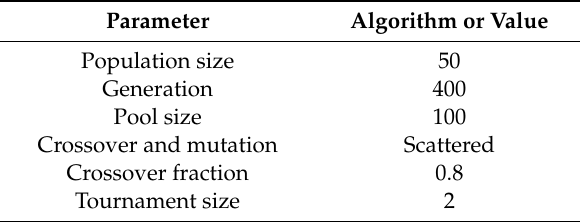
Table 2. Parameters associated with